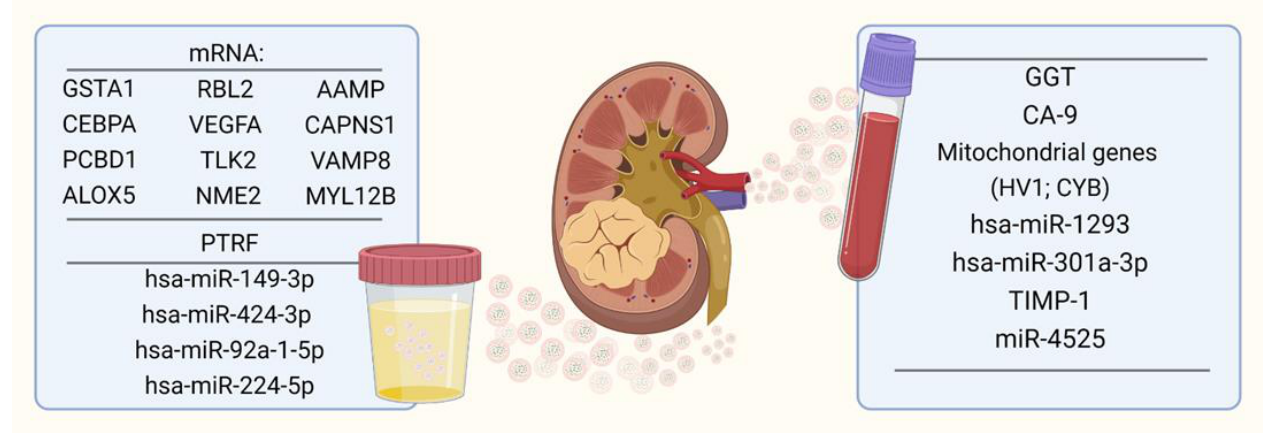
Figure 2. EV-associated biomarkers and prognostic factors with potential impact on the immune system of RCC patients, found in urine and blood. Created with BioRender. Abbreviations: system of RCC patients, found in urine and blood. Created with BioRender. AAMP — Angio-associated migratory cell protein; ALOX5 — Arachidonate 5-lipoxygenase; CA-9 —